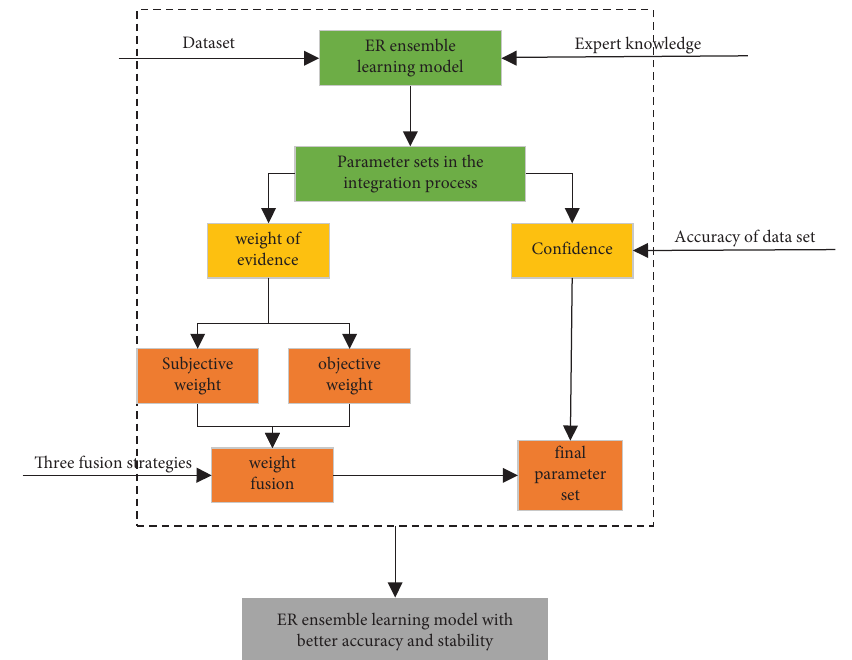
Figure 1: A new ER ensemble learning